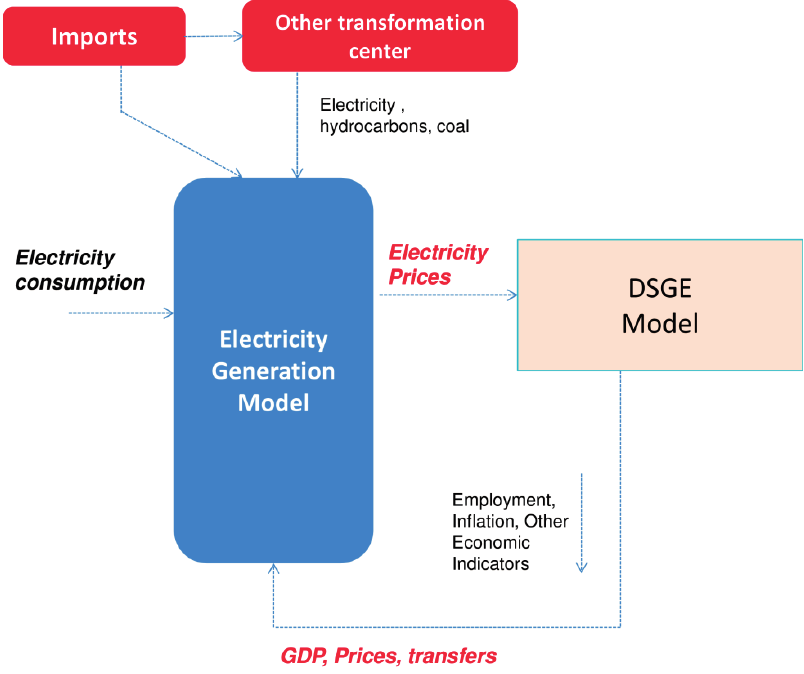
Figure 4. General description of the Chilean approach. The price of the electricity is output of the sectorial model and is an input for the DSGE